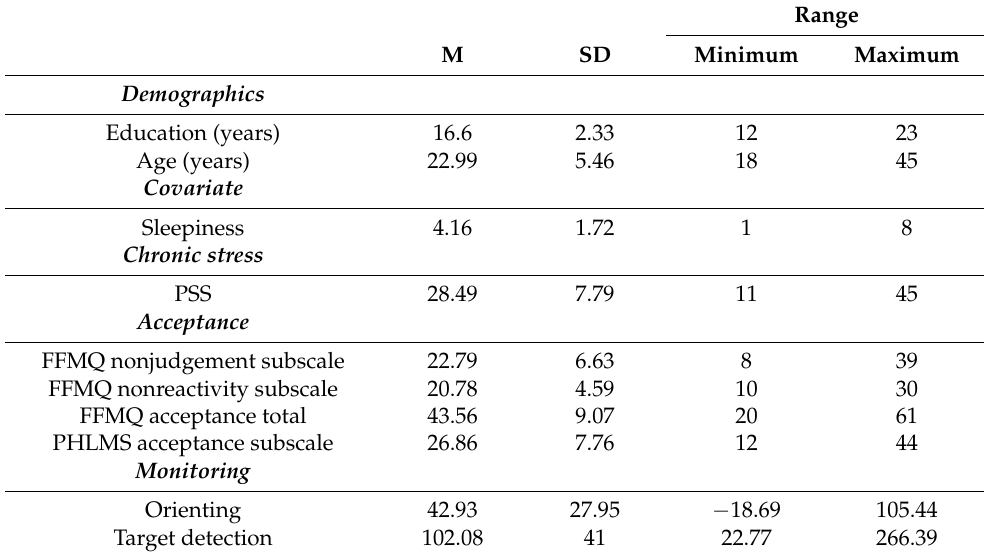
Table 1. Continuous variable descriptive statistics with means (M), standard deviations (SD), and